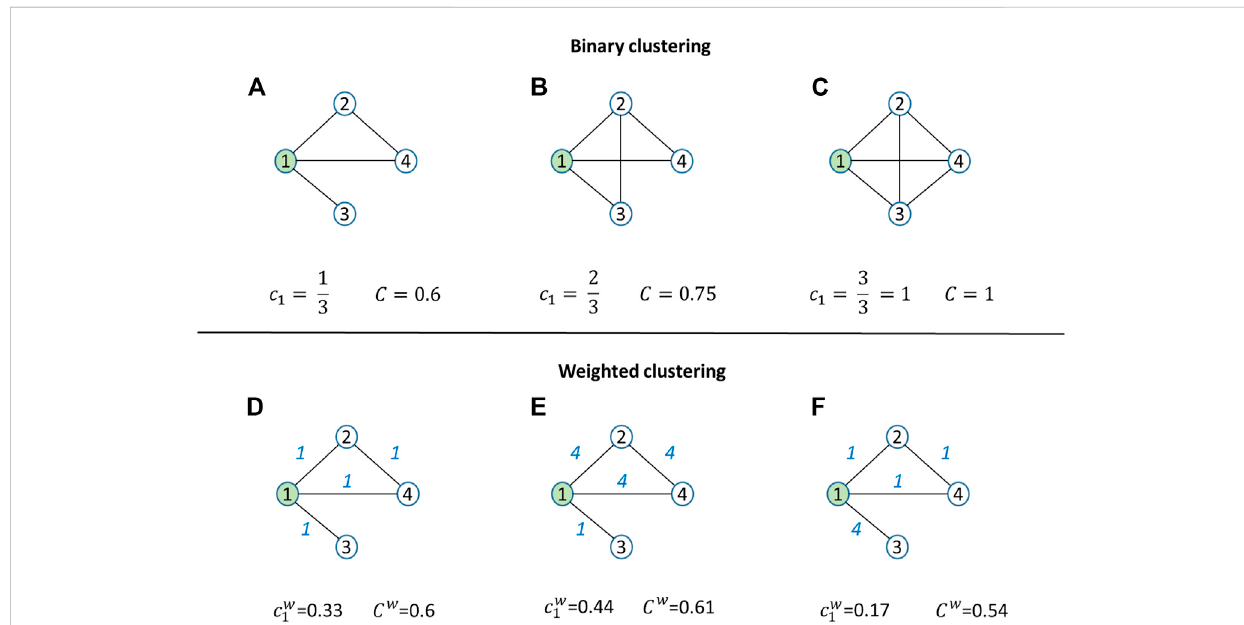
FIGURE 6 Clusteringcoef fi cientsinbinaryandweightednetworks. (A-B-C) Thebinarylocalclusteringcoef fi cient c 1 ofnode1iscomputedwithEq.6asaratio of the closed triplets on node 1 over the total number of triplets centered on node 1 (three triplets). The global clustering coef fi cient is the ratio of closed triplets over the total number of triplets computed for the whole network (Eq. 8). In the network (A) , there is only one closed triplet over the three total (cid:2) 0 . 6. In the network (B) , there are two closed triplets over the three total , and the global clustering is C (cid:2) 3 triplets, the clustering of node 1 is c 1 (cid:2) 1 3 5 (cid:2) 0 . 75. In the complete network (C) , all the triplets are closed with c (cid:2) 3 triplets, thus c 1 (cid:2) 2 , and the global clustering is C (cid:2) 6 and C (cid:2) 1. (D) Weighted 1 3 8 3 network in which the link weight is uniform and equals 1. In this network, the weighted clustering coef fi cient computed using Eq. 9 and its global version C w return the same value for both the local and global binary clustering coef fi cients in panel (A) . (E) Weighted clustering coef fi cient of node 1 in a weighted network in which the closed triplet is made by strong links. (F) Weighted clustering coef fi cient of node 1 in a weighted network in which the closedtripletismadebyweaklinks.Theweightedlocalclusteringcoef fi cient c w 1 ofnode1ishigherwhentheclosedtripletsonnode1aremadeofstrong links (panel E )than in the case where the closed triplets are built by weak links (panel F ). Analogously, the global clustering coef fi cient in its global version C w is higher when the closed triplets are composed of strong links (as in E ).